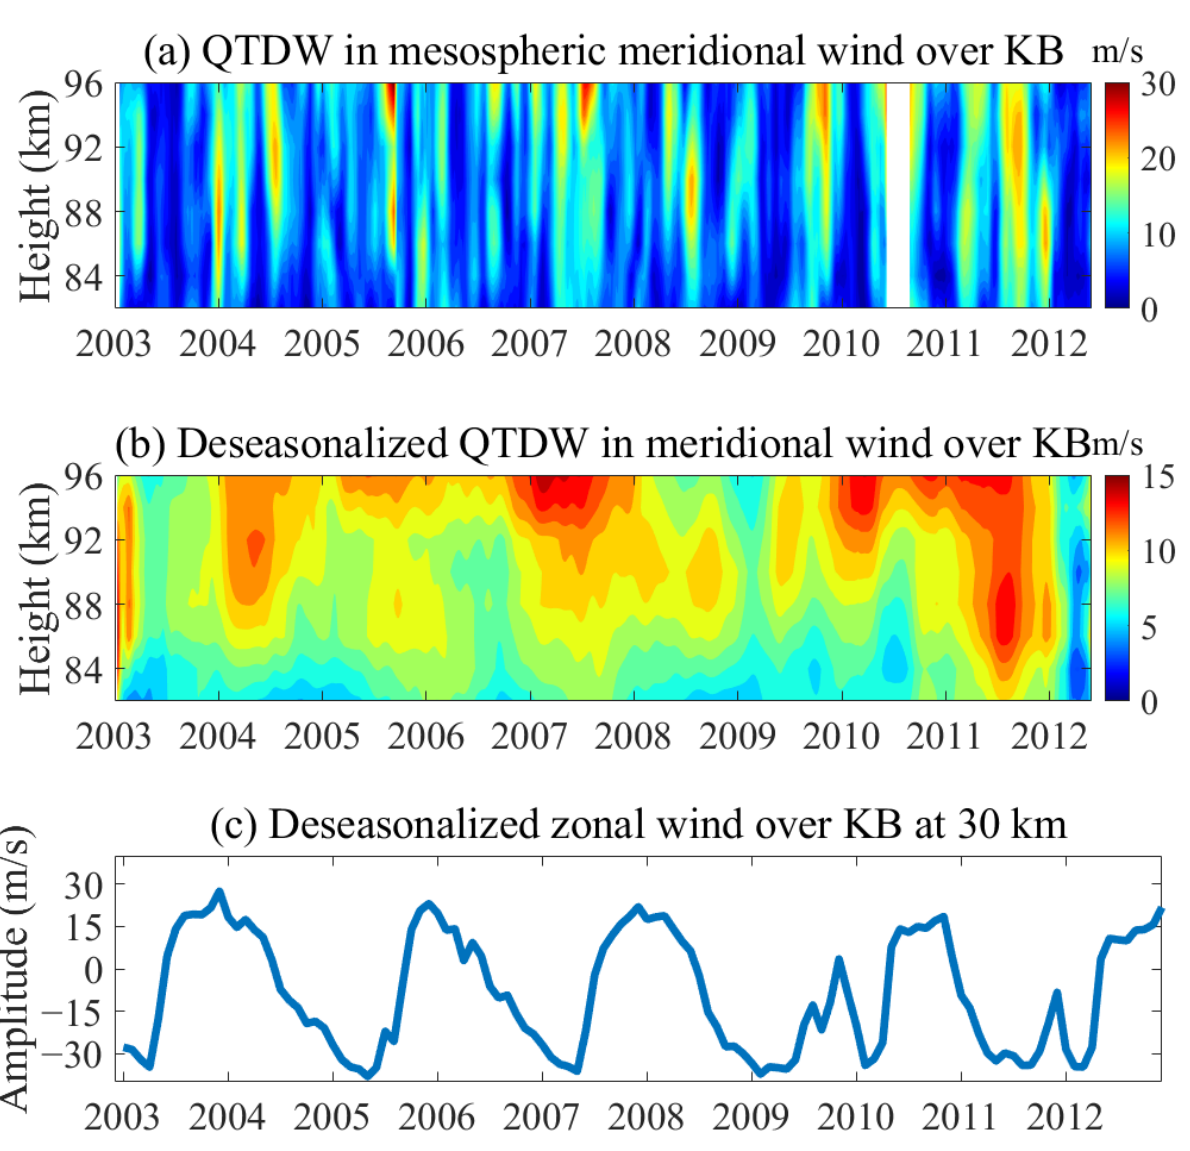
Figure 7. ( a ) QTDWs in the mesospheric meridional wind from meteor radar over KB. ( b ) Deseasonalized QTDWs in mesospheric meridional wind over KB. ( c ) Amplitudes of deseasonalized monthly mean zonal wind at 30 km from 2003 to 2012.